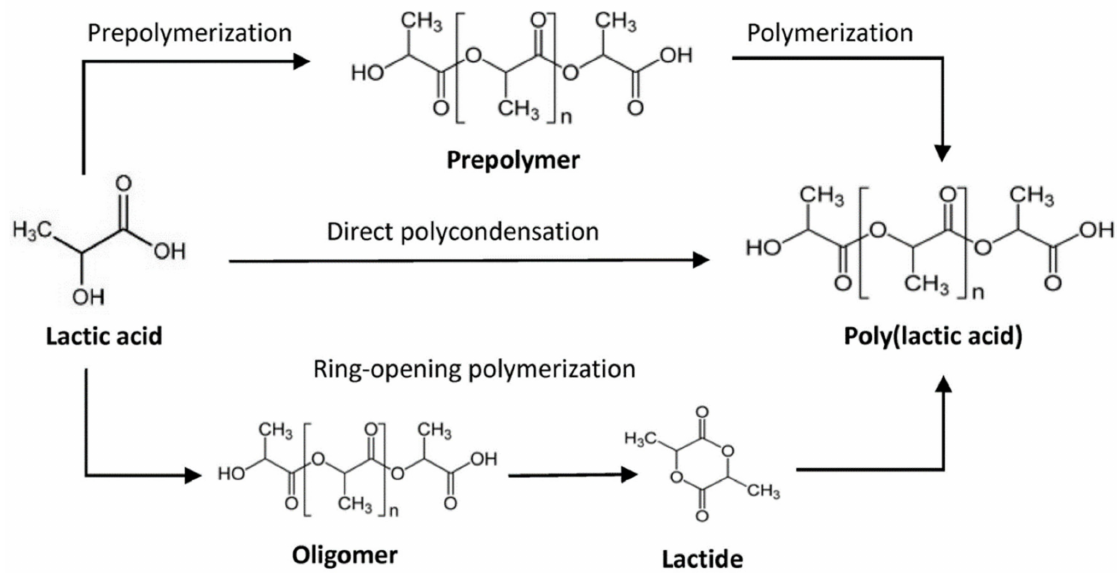
Figure 5. Routes of poly(lactic acid) (PLA) synthesis from lactic acid